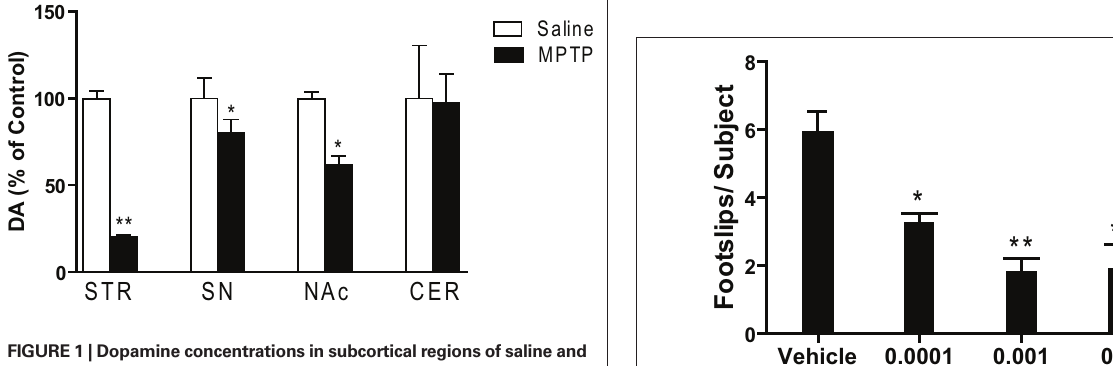
Figure 1 | Dopamine concentrations in subcortical regions of saline and MPTP-treated mice. Dopamine concentrations were determined 3 weeks